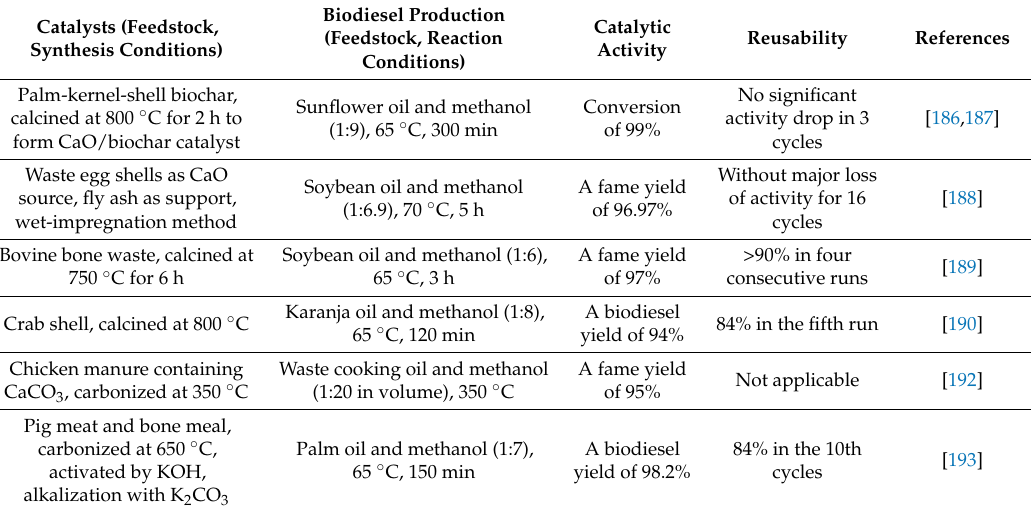
Table 3. Biochar-based solid-alkali catalysts for biodiesel production. FAME: fatty acid methyl ester. Catalysts (Feedstock, Synthesis